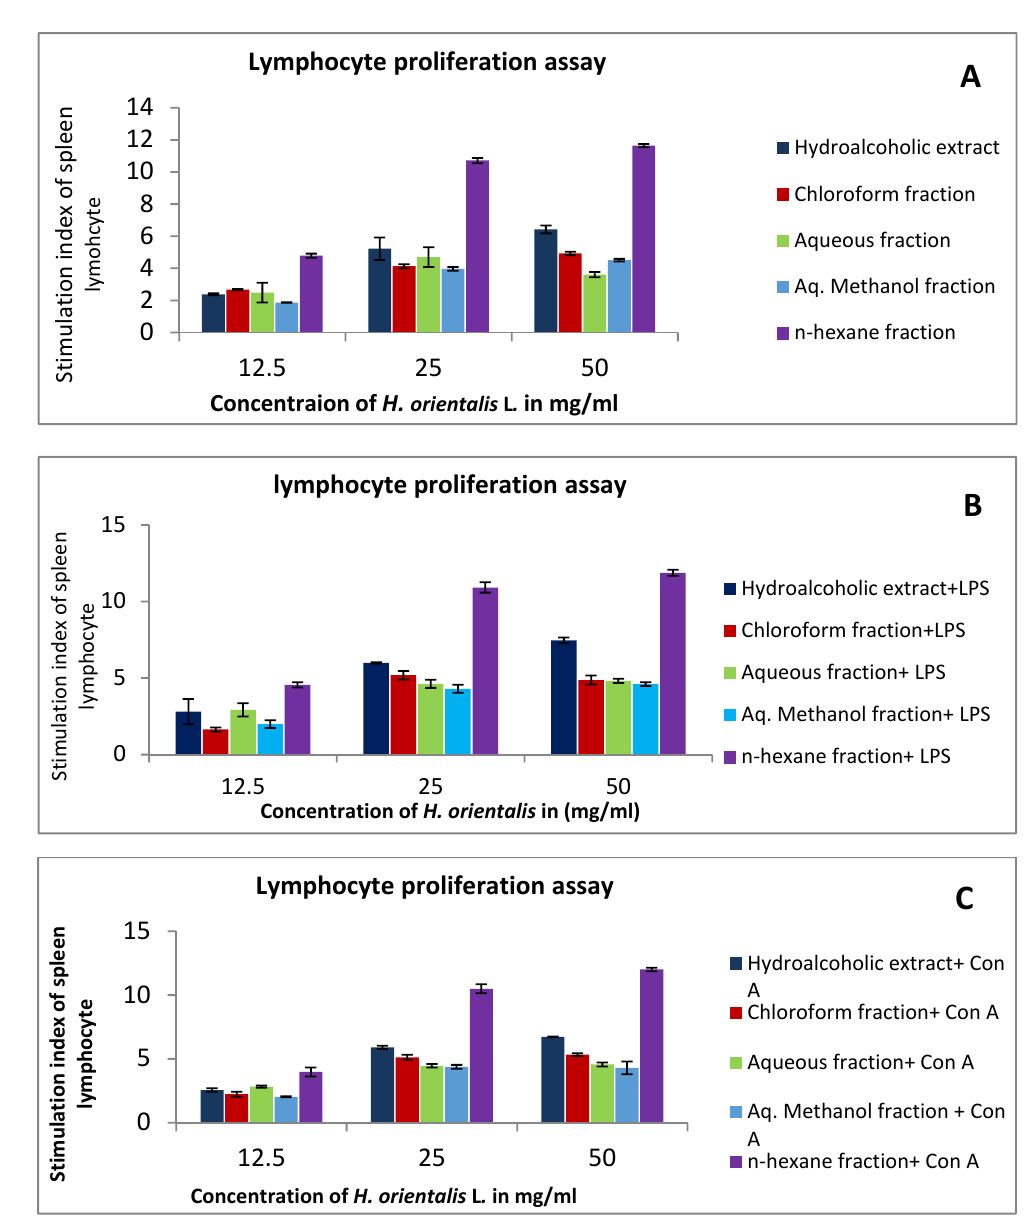
Figure 3. The effect of H. orientalis L. extract and fractions on the splenic lymphocytes’ proliferation using different concentrations (12.5–50 mg/mL) in the presence and absence of mitogens: ( A ) in the absence of Con A (concanavalin A) and LPS (lipopolysaccharide); ( B ) in the presence of (4 µ g/mL) of LPS; ( C ) in the presence of (5 µ g/mL) of Con A. Results are expressed as means (bars) ± SEM (lines).